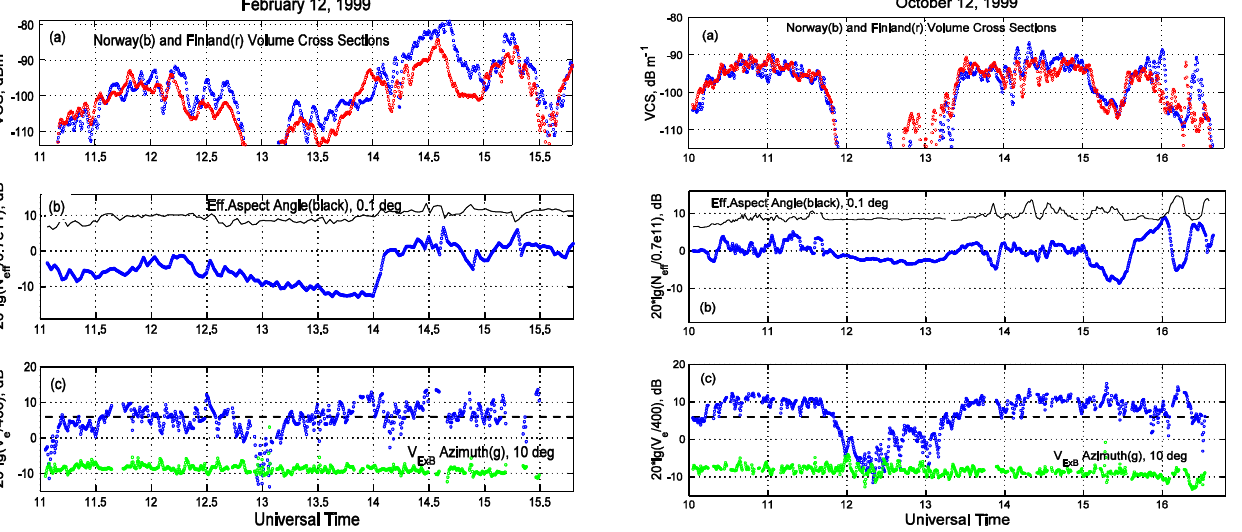
Fig. 3. The same as in Fig. 2 but for 12 October Fig. 2. (a) The volume cross sections, σ v , on logarithmic scale corrected on the backscatter volume height thickness and aspect an- gle, Eq. (3), for the Norway and Finland STARE radars, blue and red line, respectively, for 12 February 1999; (b) The effective elec- tron density in the STARE radar backscatter volumes on logarith- mic scale, blue line, and the effective aspect angle on linear scale, black line, both inferred from the EISCAT N(h) -profiles, Eqs. (5) and (4); (c) The mean electron drift velocity (on logarithmic scale) and azimuth (on linear scale) in the STARE backscatter volume ob- tained from the tri-static EISCAT CP1 measurements, blues and green line respectively. Logarithmic scales in panels (a) , (b) and (c) were used intentionally to show the expected σ v dependence D E 1 / 2 ∝ V E × B ) according to (δN/N) 2 upon (N eff e ) 2 and V 2 (if E × B Eq. (1). LT=UT+2h.